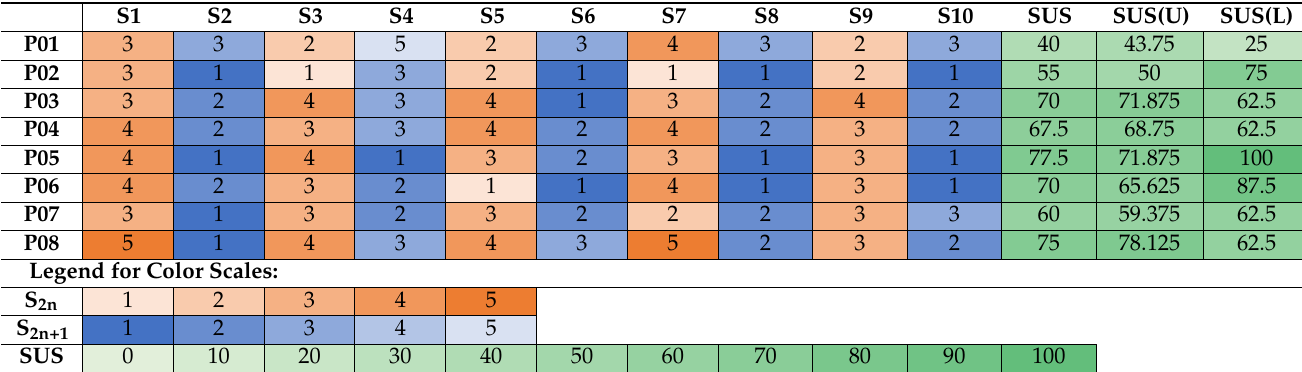
Table A2. Results of the application of the SUS questionnaire to eight physiotherapists at